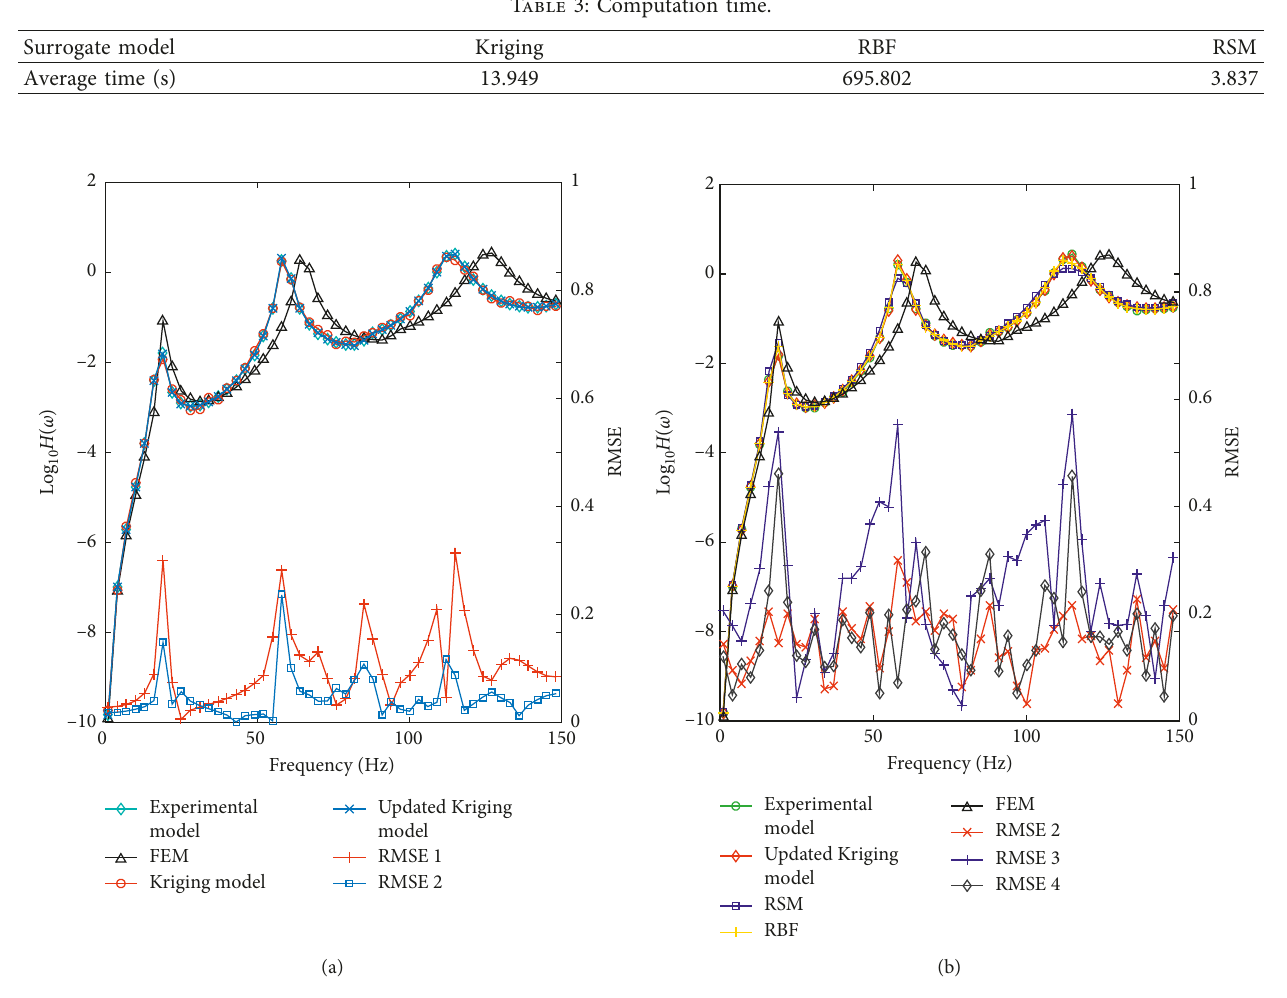
Figure 8: Log(FRF) of experimental model. (a) Comparison of the updated Kriging model with the Kriging model. (b) Comparison of the updated Kriging model with RBF and